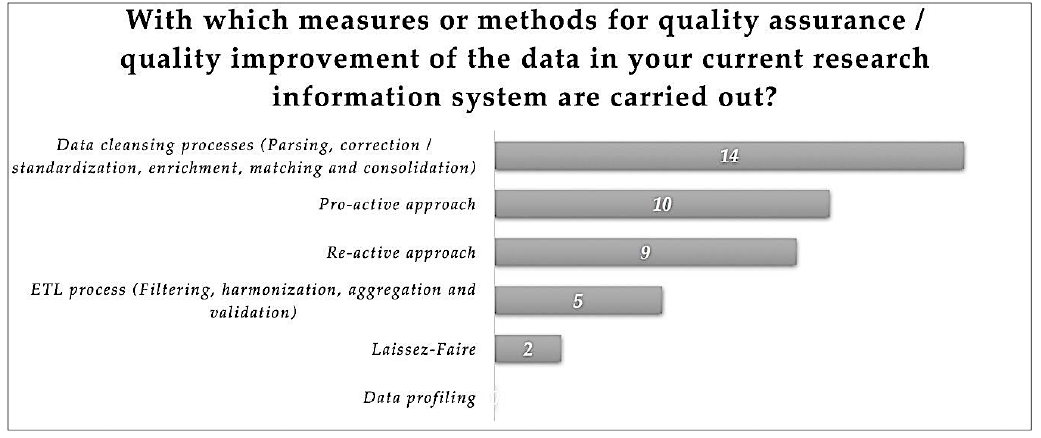
Figure 7. Measures and methods for quality assurance and quality improvement of CRIS data ( N = 17 ).